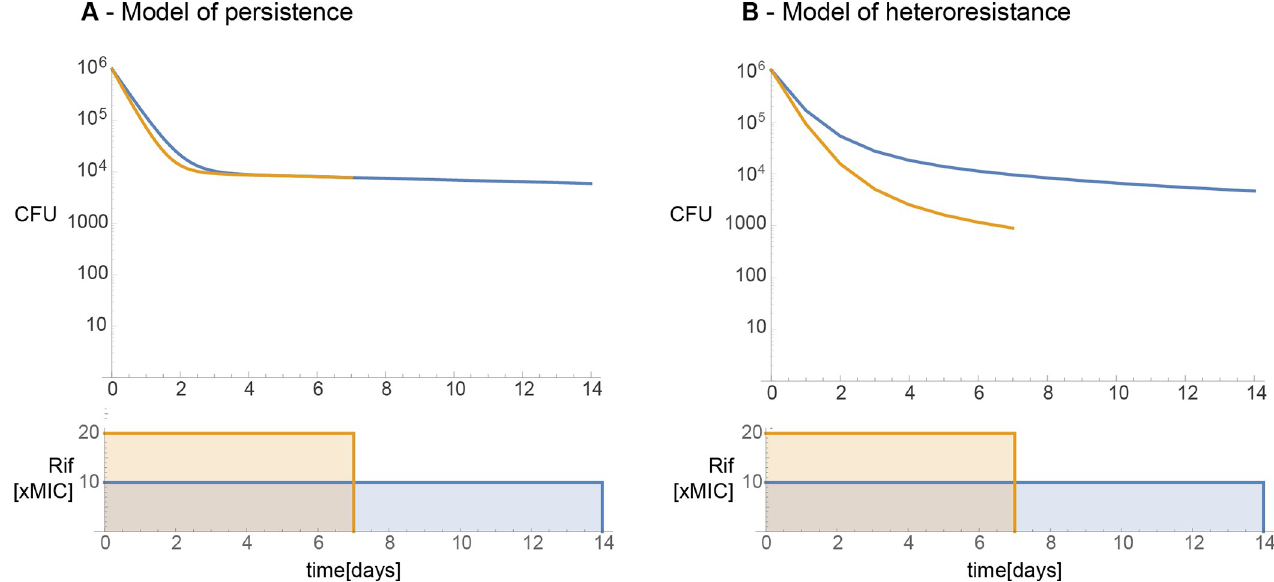
Fig 3. Predicted responses of the mathematical models of persistence and heteroresistance. This figure shows the qualitative difference between the causes behind the slowdown in bacterial decline. The top row shows bacterial counts (Y-axis) over time (X-axis) for two different idealized dosing regimens (orange and blue curves). The bottom row shows the two simplified exposure profiles: both have the same AUC but different Cmax values. Fig 3A shows that if the slowdown in decline is a result of switching between susceptible and non-susceptible states, then the slope of the slow phase is not dependent on C max . On the other hand, Fig 3B shows that if the slowdown in decline is the result of a diversity in the susceptibility to antibiotics, then a change in antibiotic concentrations should affect the slope of the slow phase as well.